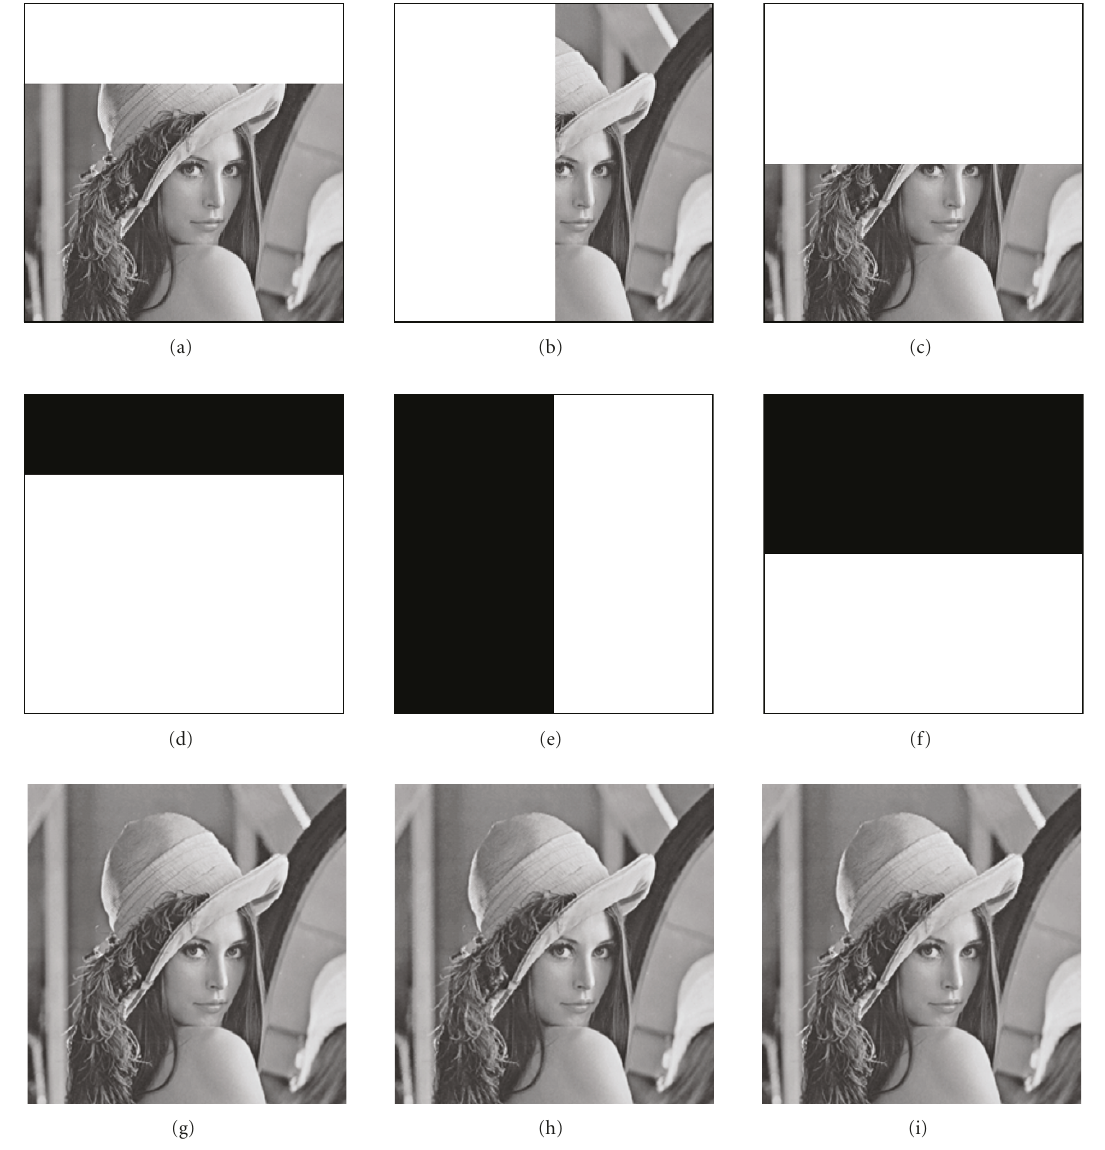
Figure 6: The cropping attack experiments: (a) 25% of the watermarked image Lena (W) is cropped; (b) a vertical cropping of 50%; (c) a horizontal cropping of 50%; (d)–(f) the detected tampered blocks of (a)–(c), respectively; (g)–(i) the images recovered from (a)–(c), respectively. The PSNR values are 40.04 dB for (g); 34.77 dB for (h); and 36.54 dB for (i).